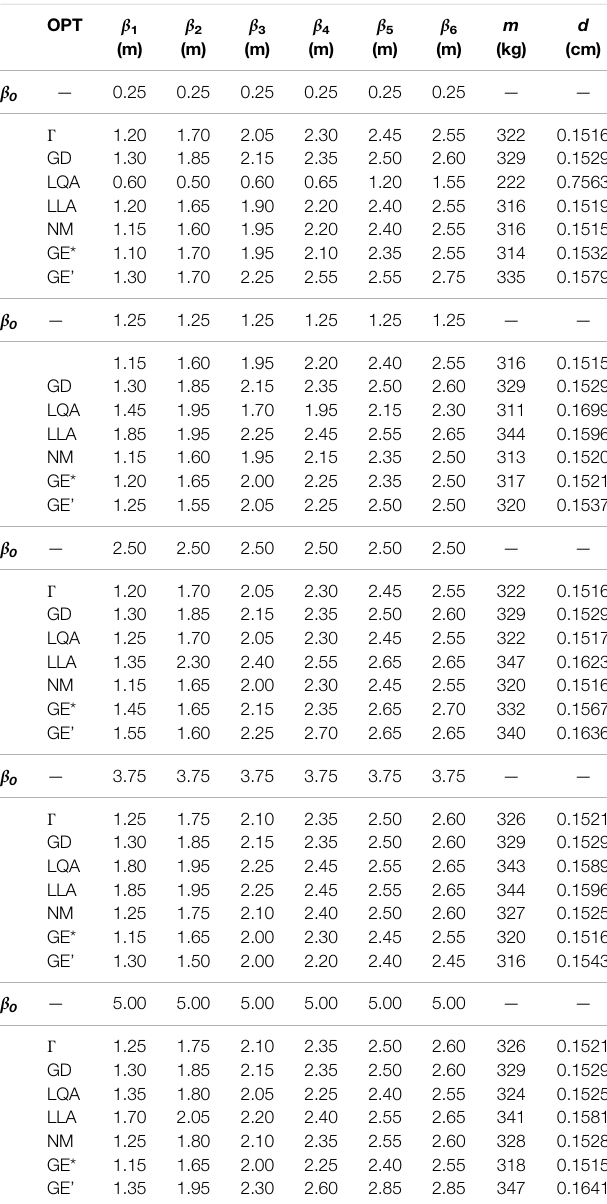
TABLE1| Resultsofparameters β 1 , ... , β 6 fordifferentinitial β 0 ( Figure6 ),mass m ( Eq. 6 ), and deformation d ( Eq. 5 ) of optimization algorithms OPT with maximum run-time of that needed by the Γ operator ( Figure 1A ) as early stop criterion; GOAT-algorithms( Figure 3 ):GD = global deterministic (DIRECT),LQA = local quadratic approximation (BOBYQA), LLA = local linear approximation (COBYLA), NM = Nelder – Mead (SUBPLEX), GE* and GE ’ = global evolutionary(CRS2) best* and worst ’ result of5runs; visualization oftheresult of the Γ -operator for β 0 = (2.5 2.5 2.5 2.5 2.5 2.5) T ( Figure 6E ).